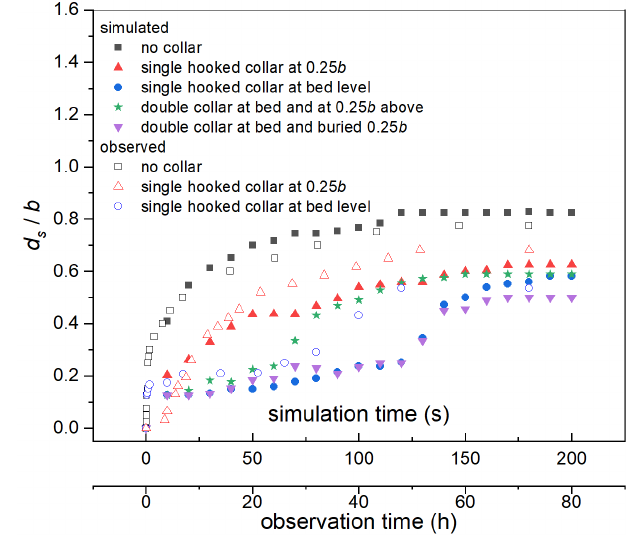
Figure 4. Scour development for the different hooked-collar